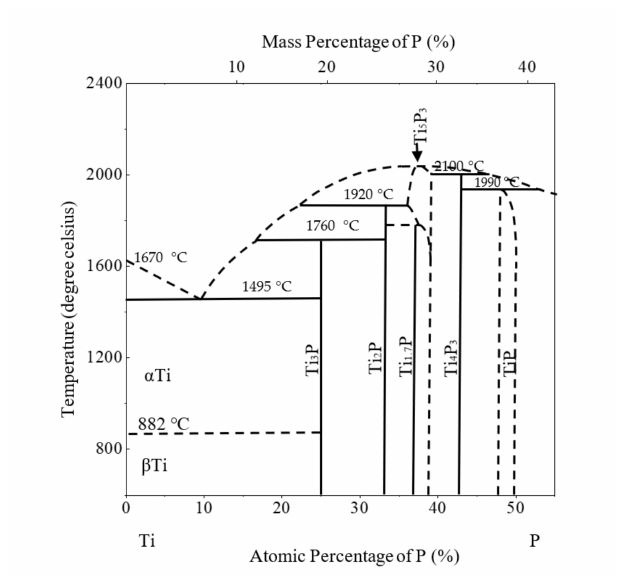
Figure 7. Ti-P binary phase diagram.